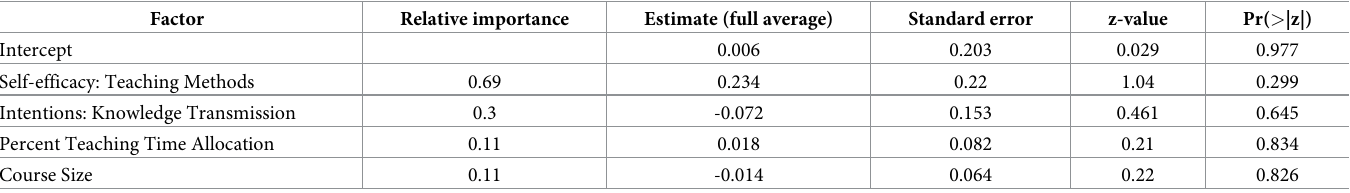
Table 4. Average model results for the change in RTOP scores for FIRST IV faculty, from the end of FIRST IV to 6–9 years later (N = 31).